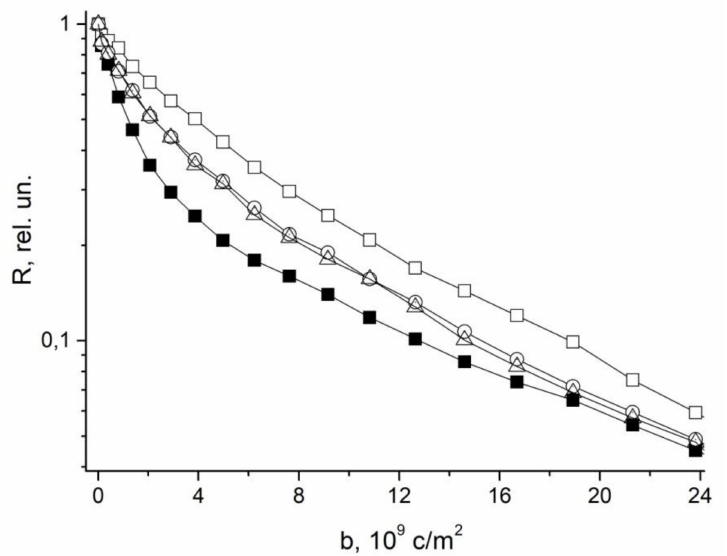
Figure 20. Diffusion decay for root segments: Control (solid square), 20 min treatment with sodium azide of different concentration: 0.01 M (open square), 0.001 M (open circle), 0.0005 M (open trian- gle)